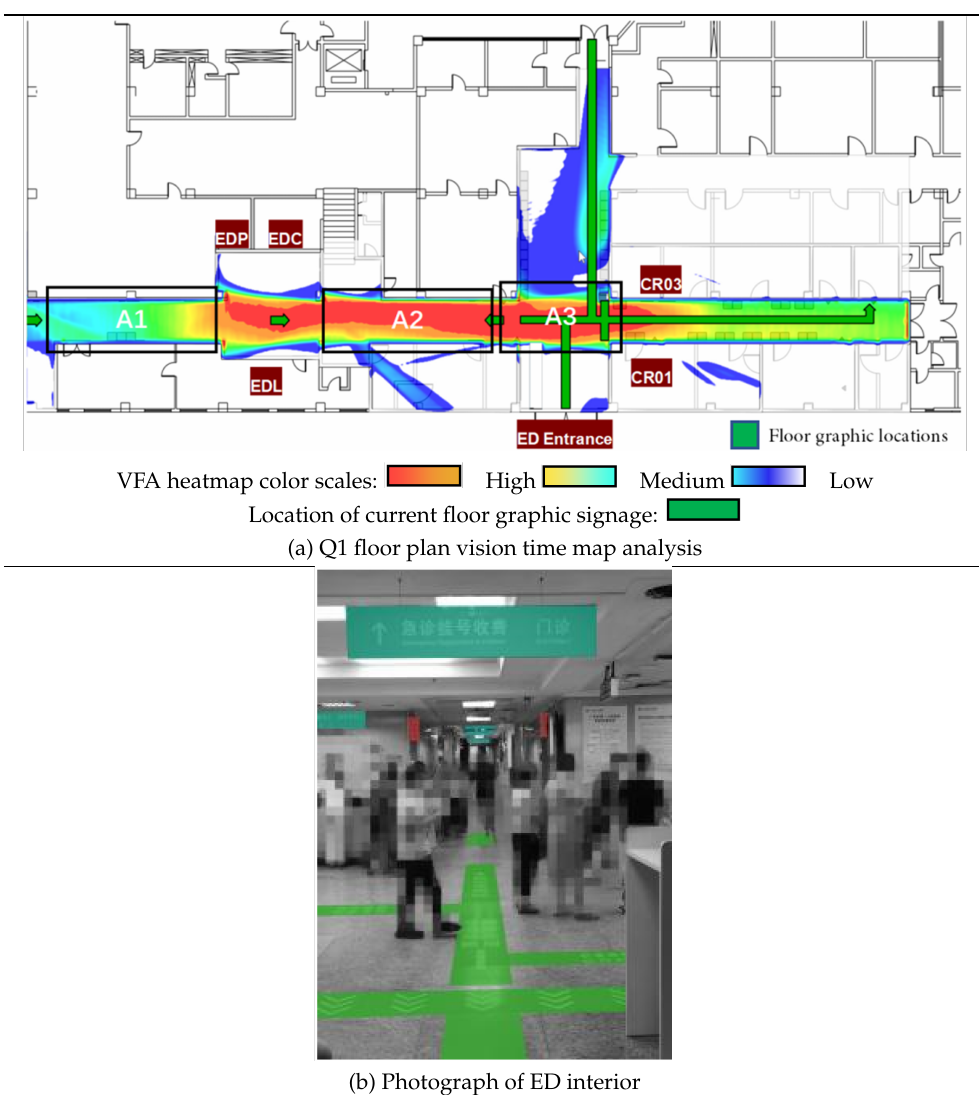
Table 22. Q1 floor graphic